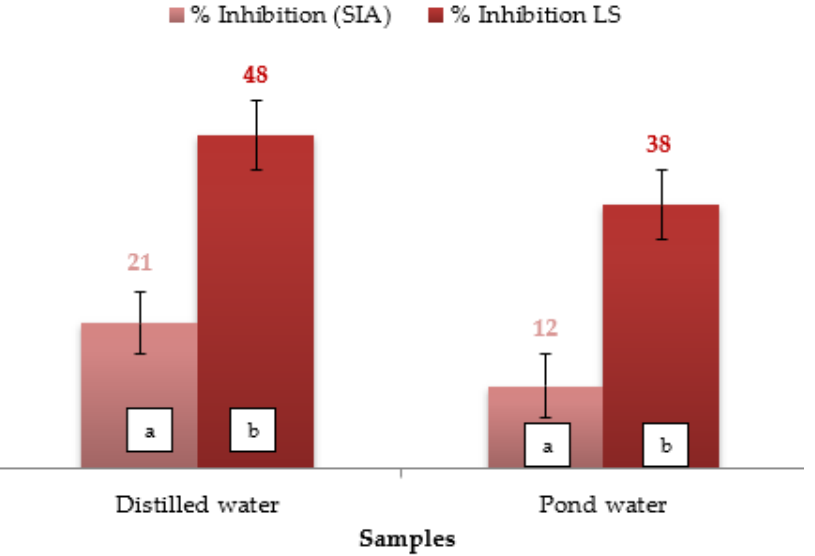
Figure 1. The process of phytotoxicity test and measurement parameters of leachate.